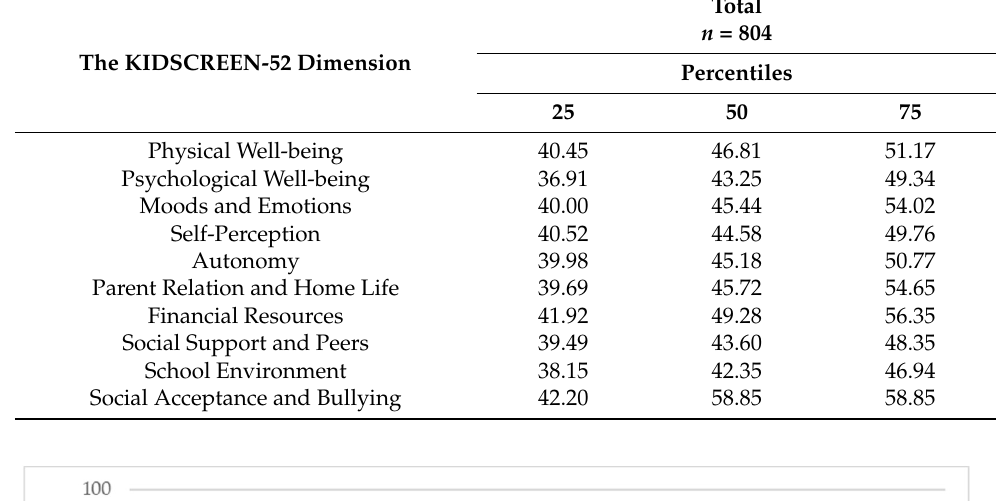
Table 2. The quality of life in adolescents in 10 KIDSCREEN-52 dimensions (T-scores).